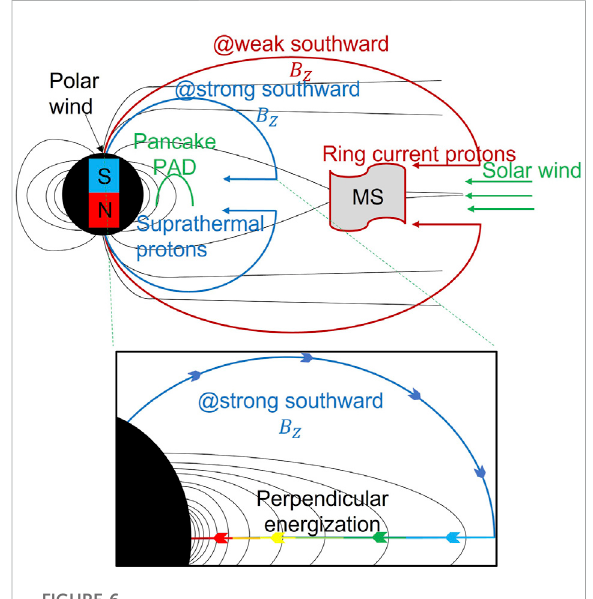
FIGURE 6 A cartoon representation of the polar wind trajectory under southward IMF B Z . Top panel shows the variation of polar wind entry point locationswith respect to thestrength of southward B Z . EntrypointmovesclosertoEarth(bluetrace)understrong B Z and the polar wind joins the warm plasma population. Weak B Z moves the polar wind entry point further away from the Earth (red trace) and polar wind enhances the ring current population, which generates MS waves. Bottom panel is the zoomed in view of the subsequent radial diffusion of the warm plasma that results in a pancake pitch angle